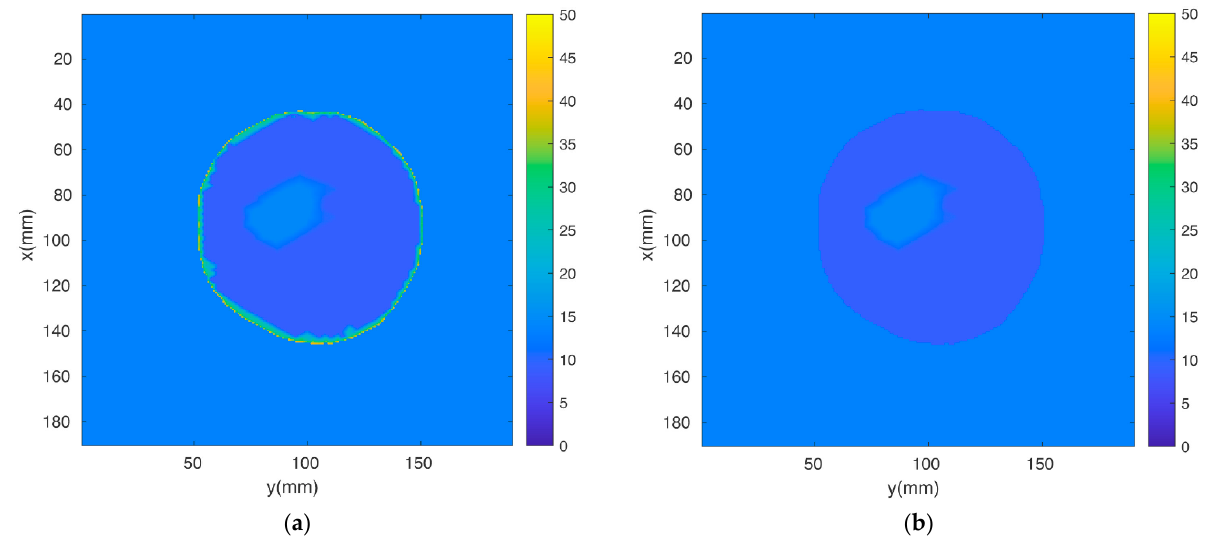
Figure 5. Two-dimensional FDTD permittivity distributions through the breast for cases ( a ) with and ( b ) without skin.